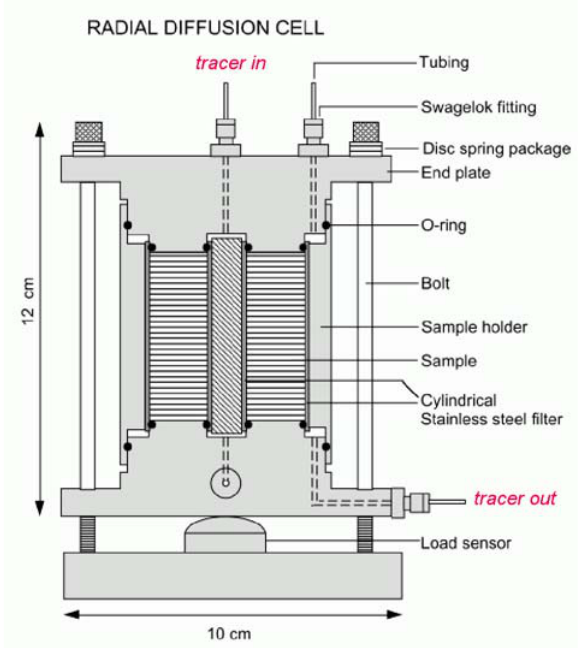
Figure 23. Radial diffusion cell used for analyzing diffusion parallel to the bedding plane of clay (Van Loon and others, 2004).